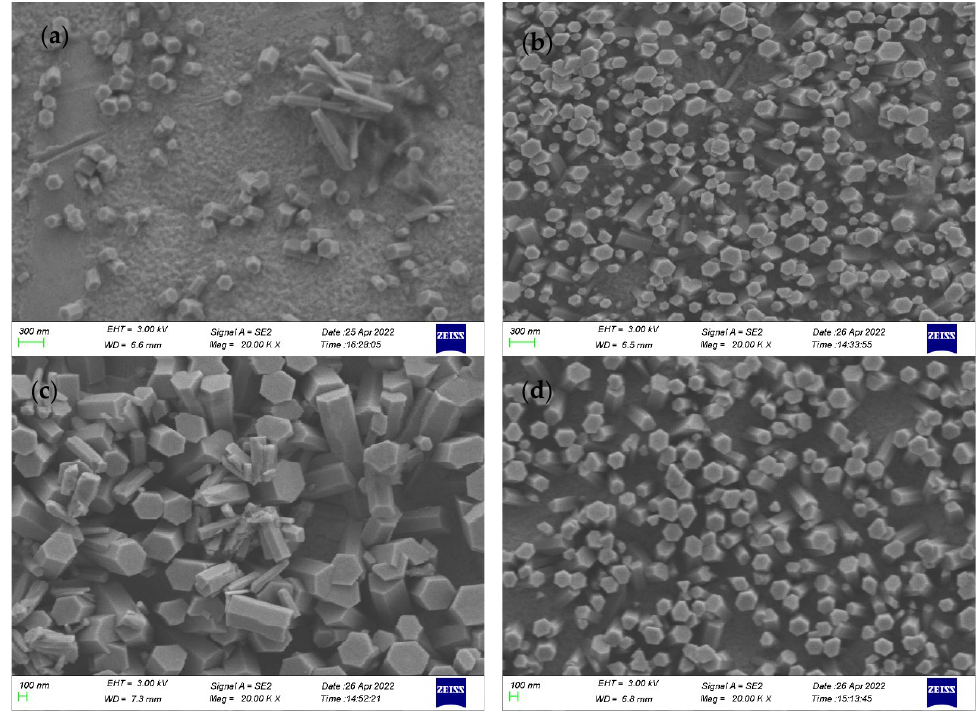
Figure 12. SEM images of ZnO nanowires grown on PCBs. ( a ) AC: 0.5 V, 1 Mz, DC1: 0.4 V, DC2: 0.4 V; ( b ) AC: 1 V, 1 Mz, DC1: 0.4 V, DC2: 0.4 V; ( c ) AC: 2 V, 1 Mz, DC1: 0.4 V, DC2: 0.4 V; ( d ) AC: 0 V, DC1: 0.4 V, DC2: 0.4 V.